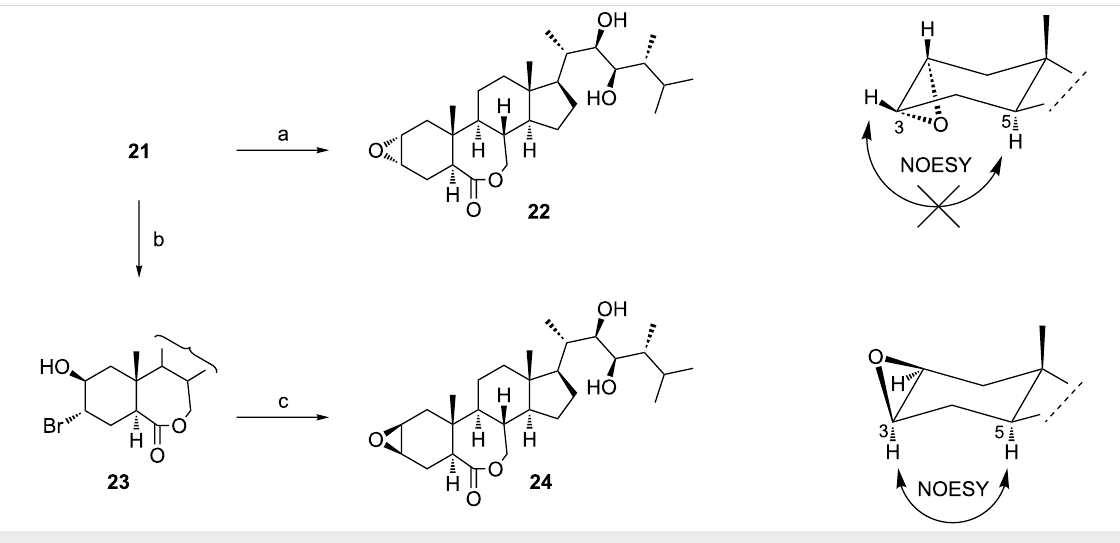
the molecule and results in the formation of 2 α ,3 α -epoxides [19]. The 7-membered B ring in 21 had no influence on the stereochemical outcome of the reaction with MCPBA which